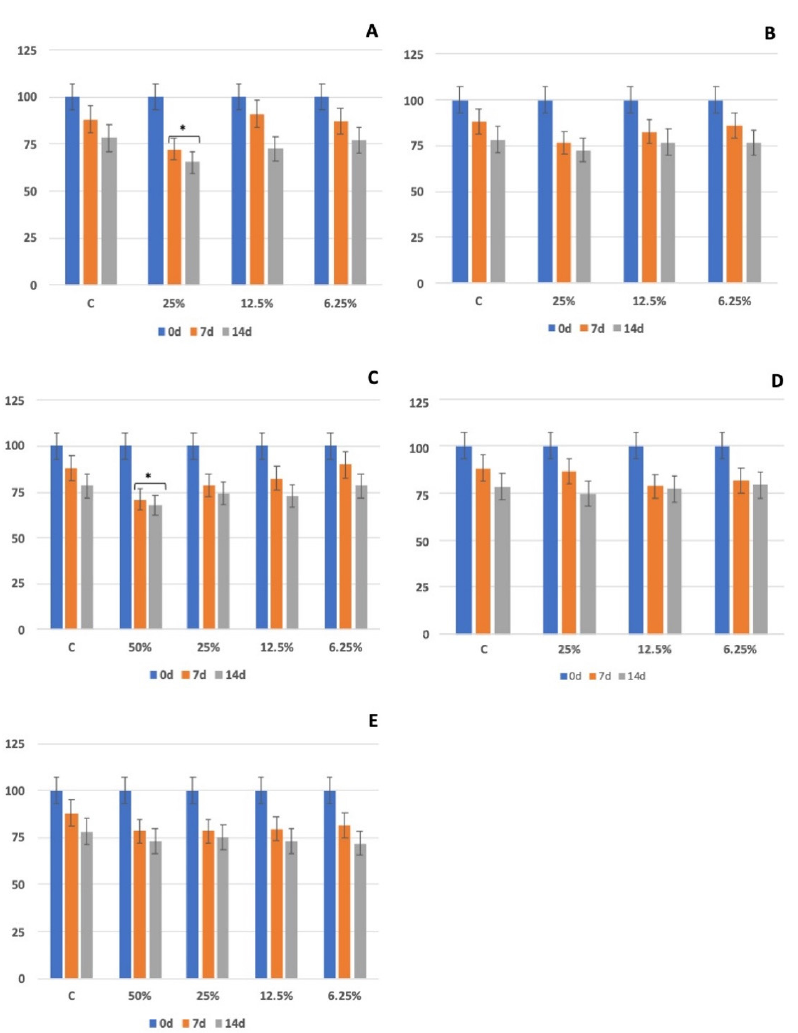
Figure 2. Earthworm weight variation at t = 0.7 and 14 days of exposure (mean ± SD, n = 10). X -axis: Soil concentration (%, w / w ). Y-axis: Earthworm weight variation (%). Analysis of variance (ANOVA) ( B ): LOS07, ( C ): LOS09, ( D ): LOS10, ( E ): LOS13.